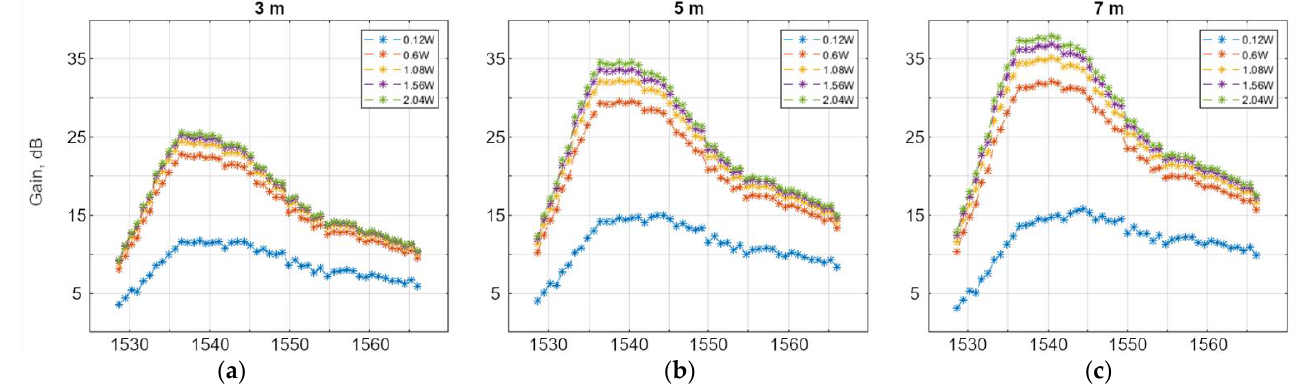
Figure 8. Simulation results showing the EYDFA gain for a − 20 dBm/ch 48-channel signal depending on the pump power (0.12–2 W) at three EYDF lengths: ( a ) 3 m, ( b ) 5 m and ( c ) 7 m. Table 2. Simulated EYDFA gain evolution. EYDF length,